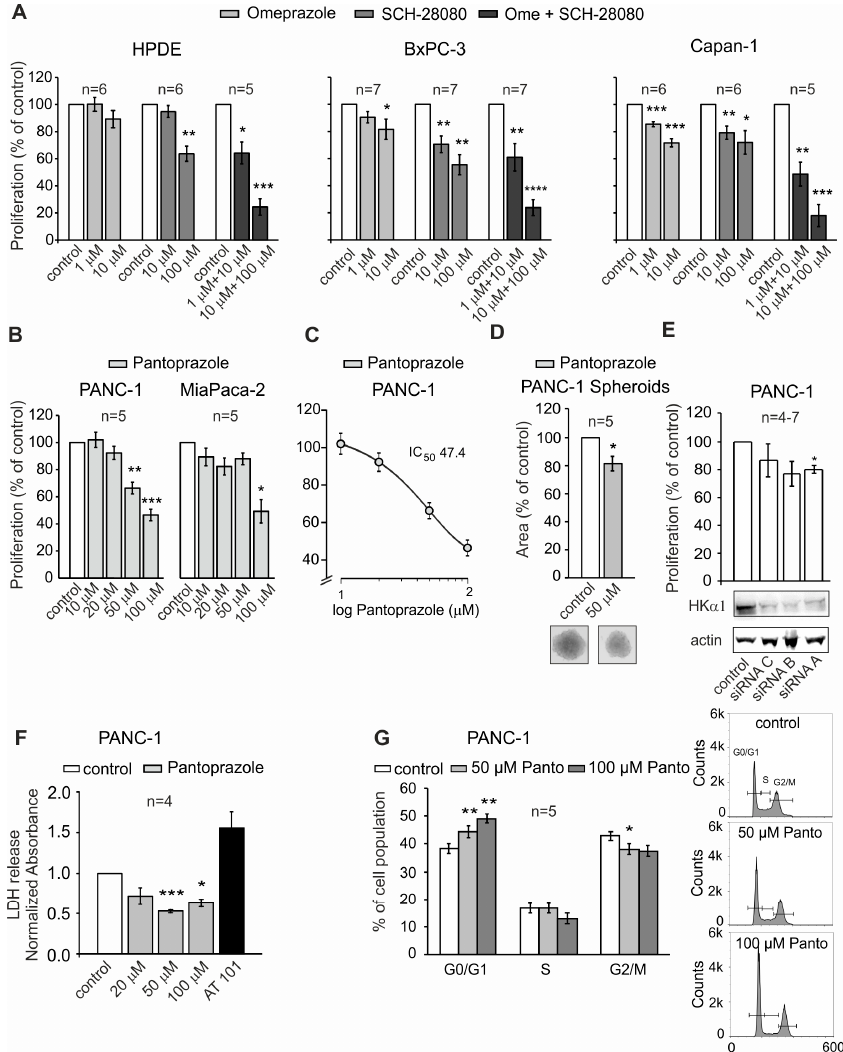
Figure 4. Role of H + , K + -ATPase in PDAC cell proliferation, cell viability and cell cycle. ( A ) E ff ect of PPIs and P-CAB on cell proliferation in HPDE (100 µ M SCH-28080: ** p = 0.0013; 1 µ M Ome + 10 µ M SCH-28080:* p = 0.0114; 10 µ M Ome + 100 µ M SCH-28080: *** p = 0.0002), BxPC-3 (10 µ M Ome: *P = 0.0485; 10 µ M SCH-28080: ** p = 0.003; 100 µ M SCH-28080: ** p = 0.001; 1 µ M Ome + 10 µ M SCH-28080: ** p = 0.0084; 10 µ M Ome + 100 µ M SCH-28080: **** p < 0.0001) and Capan-1 (1 µ M Ome: *** p = 0.0006; 10 µ M Ome: *** p = 0.0002; 10 µ M SCH-28080: ** p = 0.0083; 100 µ M SCH-28080: * p = 0.0233; 1 µ M Ome + 10 µ M SCH-28080: ** p = 0.0042; 10 µ M Ome + 100 µ M SCH-28080: *** p = 0.0006) cell lines; one-sample t-tests. Cells were incubated for 24 h with two di ff erent concentrations of omeprazole and SCH-28080, individually and together. ( B ) The e ff ect of various concentrations of pantoprazole on proliferation of PANC-1 (50 µ M:** p = 0.0042; 100 µ M:*** p = 0.0008) and MIA PaCa-2 cells (100 µ M: * p = 0.0168), one-sample t-tests and p values adjusted for multiple comparisons as more than two di ff erent conditions were tested against controls. ( C ) Dose-response curve for pantoprazole on PANC-1 cell proliferation. ( D ) E ff ect of pantoprazole treatment on PANC-1 spheroid sizes (* p = 0.0273 (one-sample t-test)). ( E ) E ff ect of three di ff erent siRNAs targeted to HK α 1 on PANC-1 cell proliferation (* p = 0.012) with respective western blot showing the e ff ectiveness of the siRNAs on HK α 1 protein expression. ( F ) E ff ect of various concentrations of pantoprazole on LDH (lactate dehydrogenase) release in PANC-1 cells. (50 µ M: *** p = 0.0008; 100 µ M: * p = 0.012 (adjusted P values, one-sample t-test) ( G ) E ff ect of pantoprazole on the di ff erent phases of the cell cycle in PANC-1 cells: G0 / G1 (** p = 0.0087; ** p = 0.0013); S (NS); G2 / M (* p = 0.0113); paired t-test). Peak count analysis is shown in the right panel. Data are shown as means ± s.e.m. from the indicated number of independent